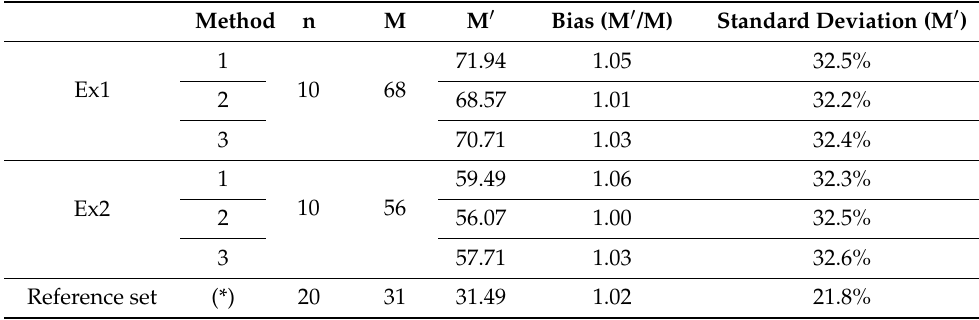
Table 5. The bias and the error comparison for methods (as in Table 4) used to estimate the Weibull